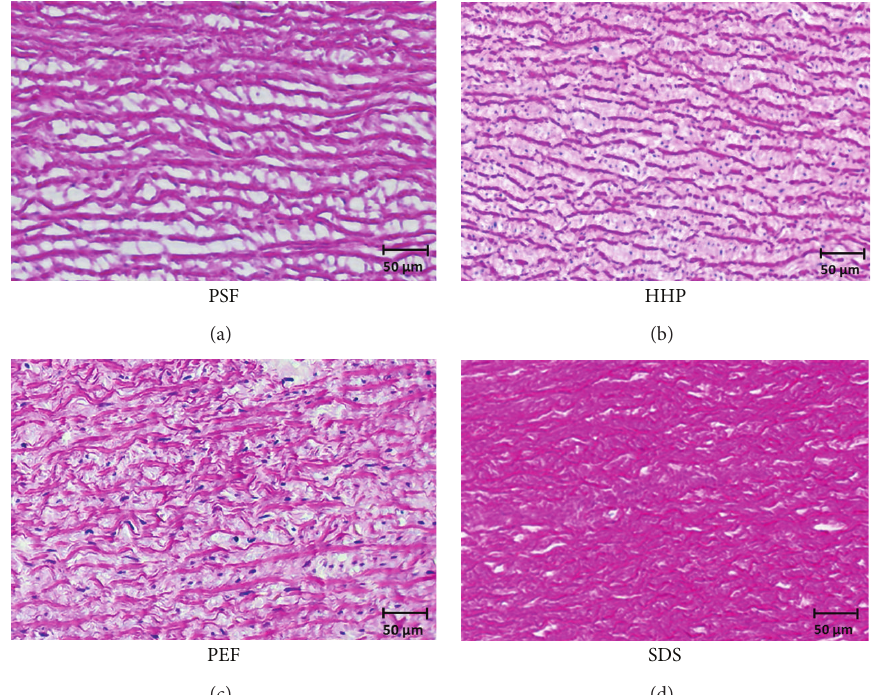
Figure 4: Images of the HE-stained sections (400x magnification). The expansion of the space between the collagen fiber filaments can be seen in the tissue treated with